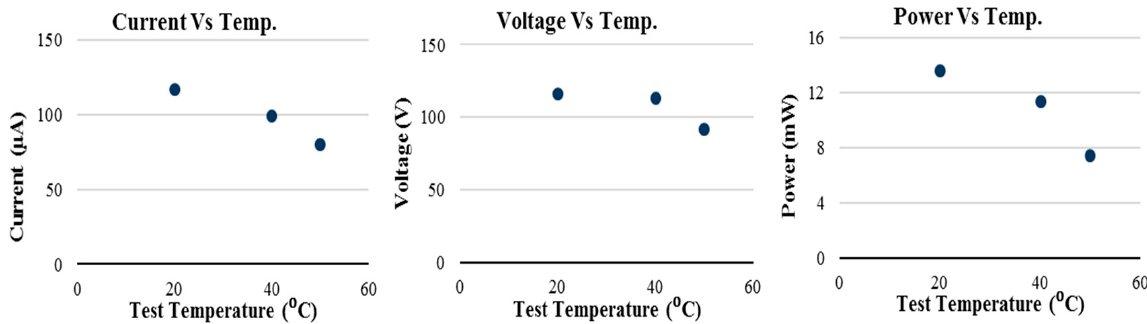
Figure 11. UTM-HiSEC Energy Generation—Temperature Variation (US 82 Type D, 1 Hz).